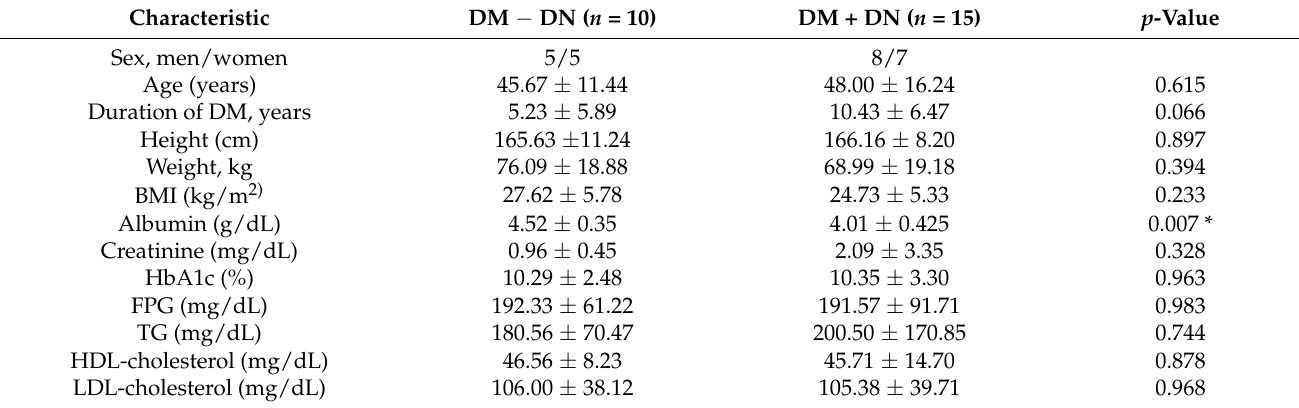
Table 2. Clinical characteristics of DM patients with or without DN. (* p <